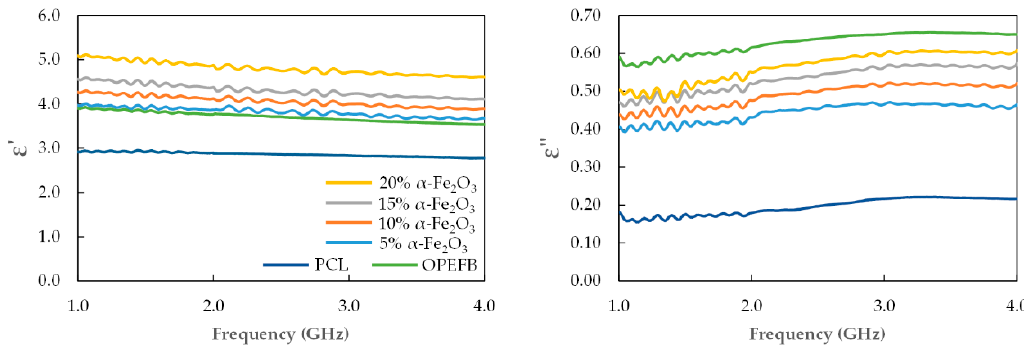
Figure 8. Complex permittivity of recycled α -Fe 2 O 3 / OPEFB / PCL nanocomposites. Table 2. Variation in ε ' and ε " values at specified frequencies. α -Fe 2 O 3 (wt.%)